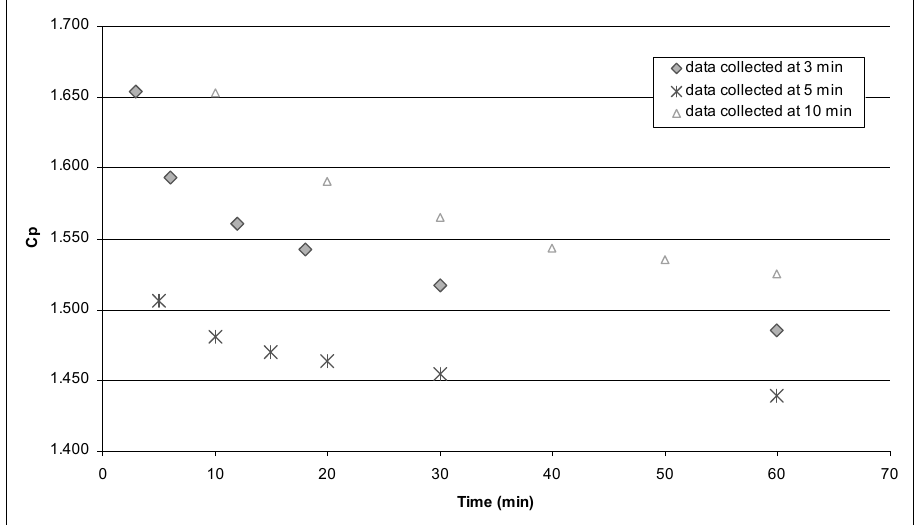
Figure 2. Effect of sampling interval (time) on peak factor.